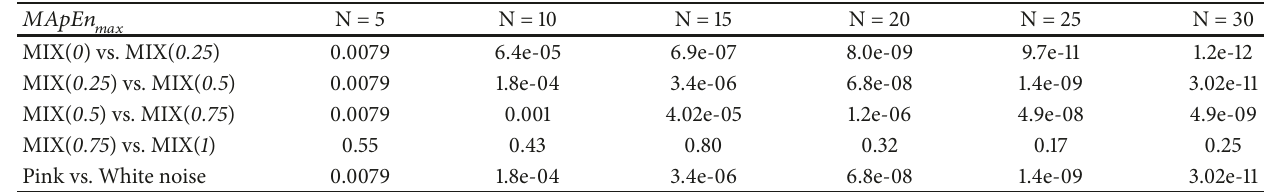
Figure 4: ApEn computed across embedding dimensions for pink noise (grey) and white noise (black) using different thresholds (a) r(m) = 0.2 and (b) r(m) = r max (m). ∗ indicates statistically significant differences by Mann-Whitney U test ( p -values < 0.05) between pink and white noise for a given embedding dimension. Data are shown as median and interquartile range over 30 realizations. Table 1: P -values from Mann-Whitney U test comparing the index 𝑀𝐴𝑝𝐸𝑛 𝑚𝑎𝑥 over different synthetic time series when varying the number N of simulated stochastic processes. 𝑀𝐴𝑝𝐸𝑛 𝑚𝑎𝑥 N = 5 N = 10 N = 15 N = 20 N = 25 N = 30 MIX( 0 ) vs. MIX( 0.25 ) 0.0079 1.2e-12 MIX( 0.25 ) vs. MIX( 0.5 ) MIX( 0.5 ) vs. MIX( 0.75 ) MIX( 0.75 ) vs. MIX( 1 ) 0.55 0.25 Pink vs. White noise